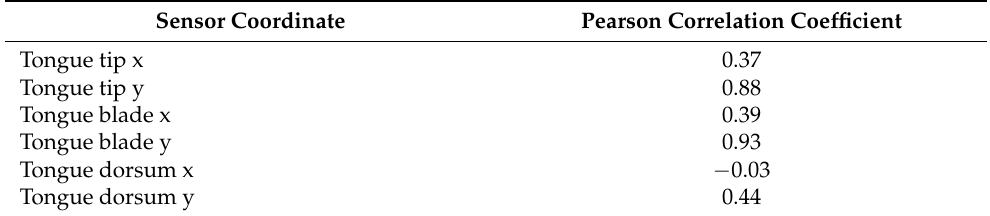
Table 6. Pearson correlation values for each sensor coordinate calculated over the five